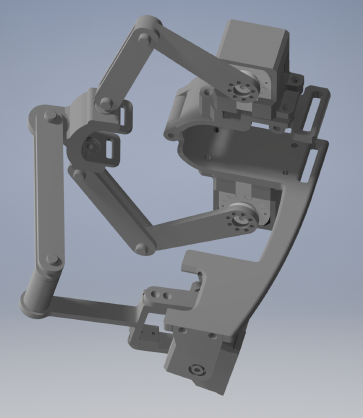
Figure 13. CAD drawing of the proposed mechanism.